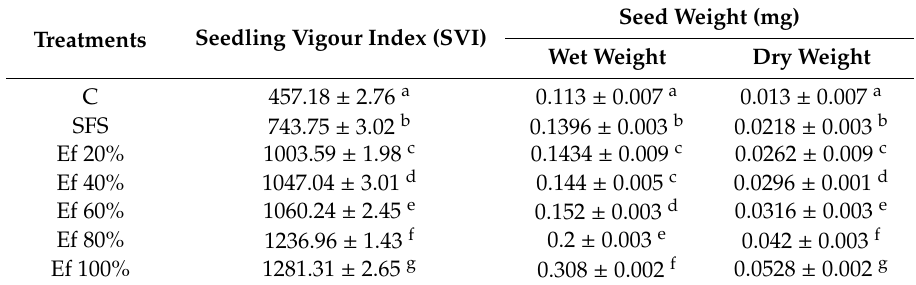
Table 4. Seedling vigour index and biomass (wet and dry weight) of tomato seeds treated with LSEs. Seed Weight (mg) Treatments Seedling Vigour Index (SVI) Wet Weight Dry Weight C 457.18 ± 2.76 a